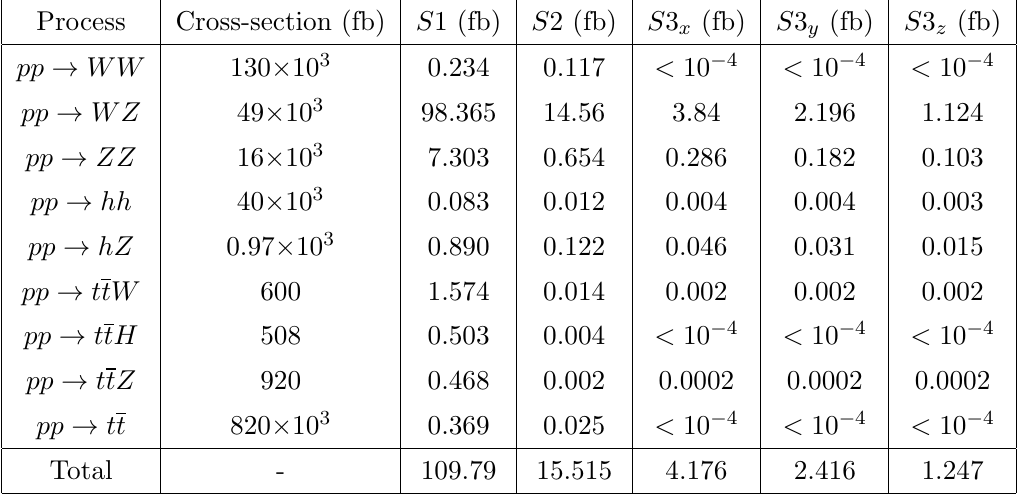
Table 5 . Background cross-sections in the 2SSL channel after passing various selection criteria at the 13 TeV